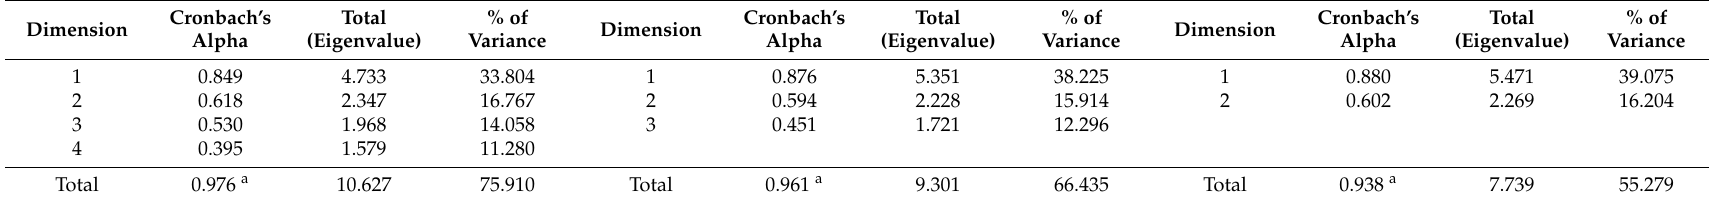
Table 6. CATPCA model summary.